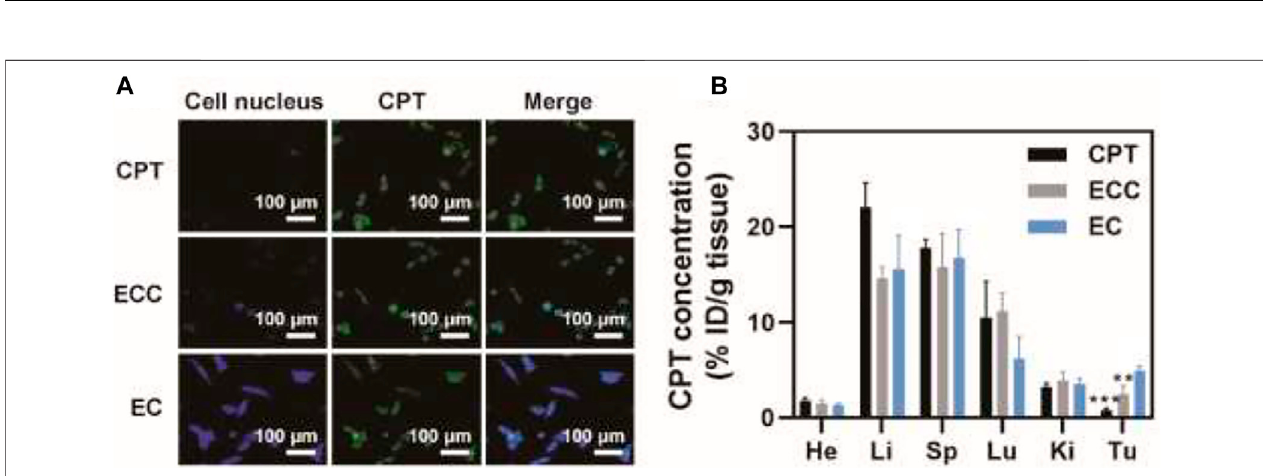
FIGURE 3 | Assessment of tumor-targeting capabilities. (A) CLSM images of patient-derived cells following CPT, ECC, and EC treatment, with CPT and mitochondria respectively shown in blue and green. (B) CPT biodistribution in mice intravenously administered with CPT, EC, and ECC. * p < 0.05, ** p < 0.01, *** p < 0.005; Student ’ s